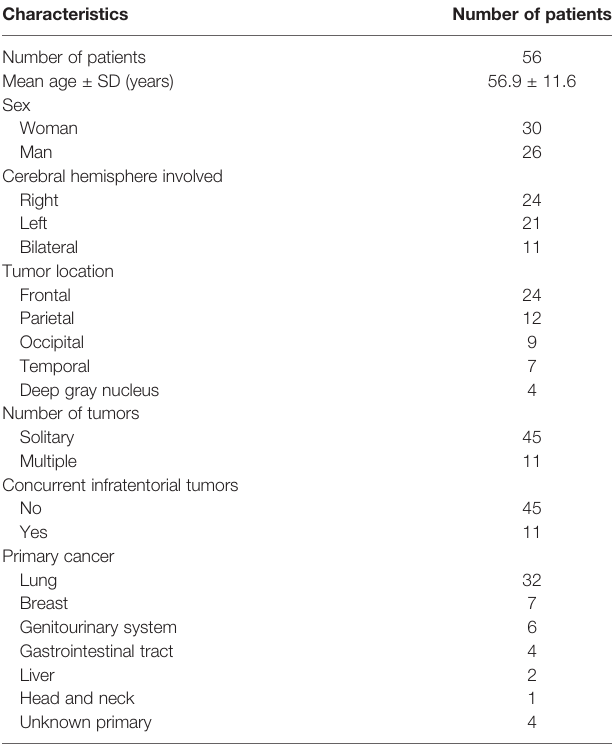
TABLE 1 | Patient